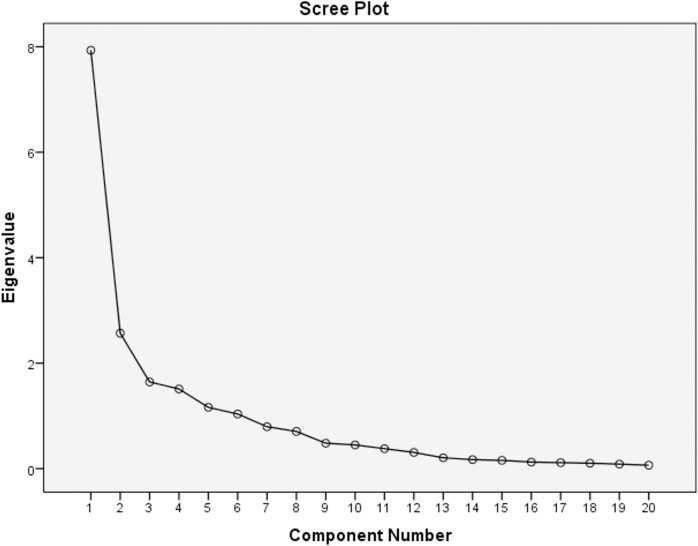
Scree plot of the eigenvalues of the factors after factor analysis.Six factors with eigenvalue > 1.0 were found.